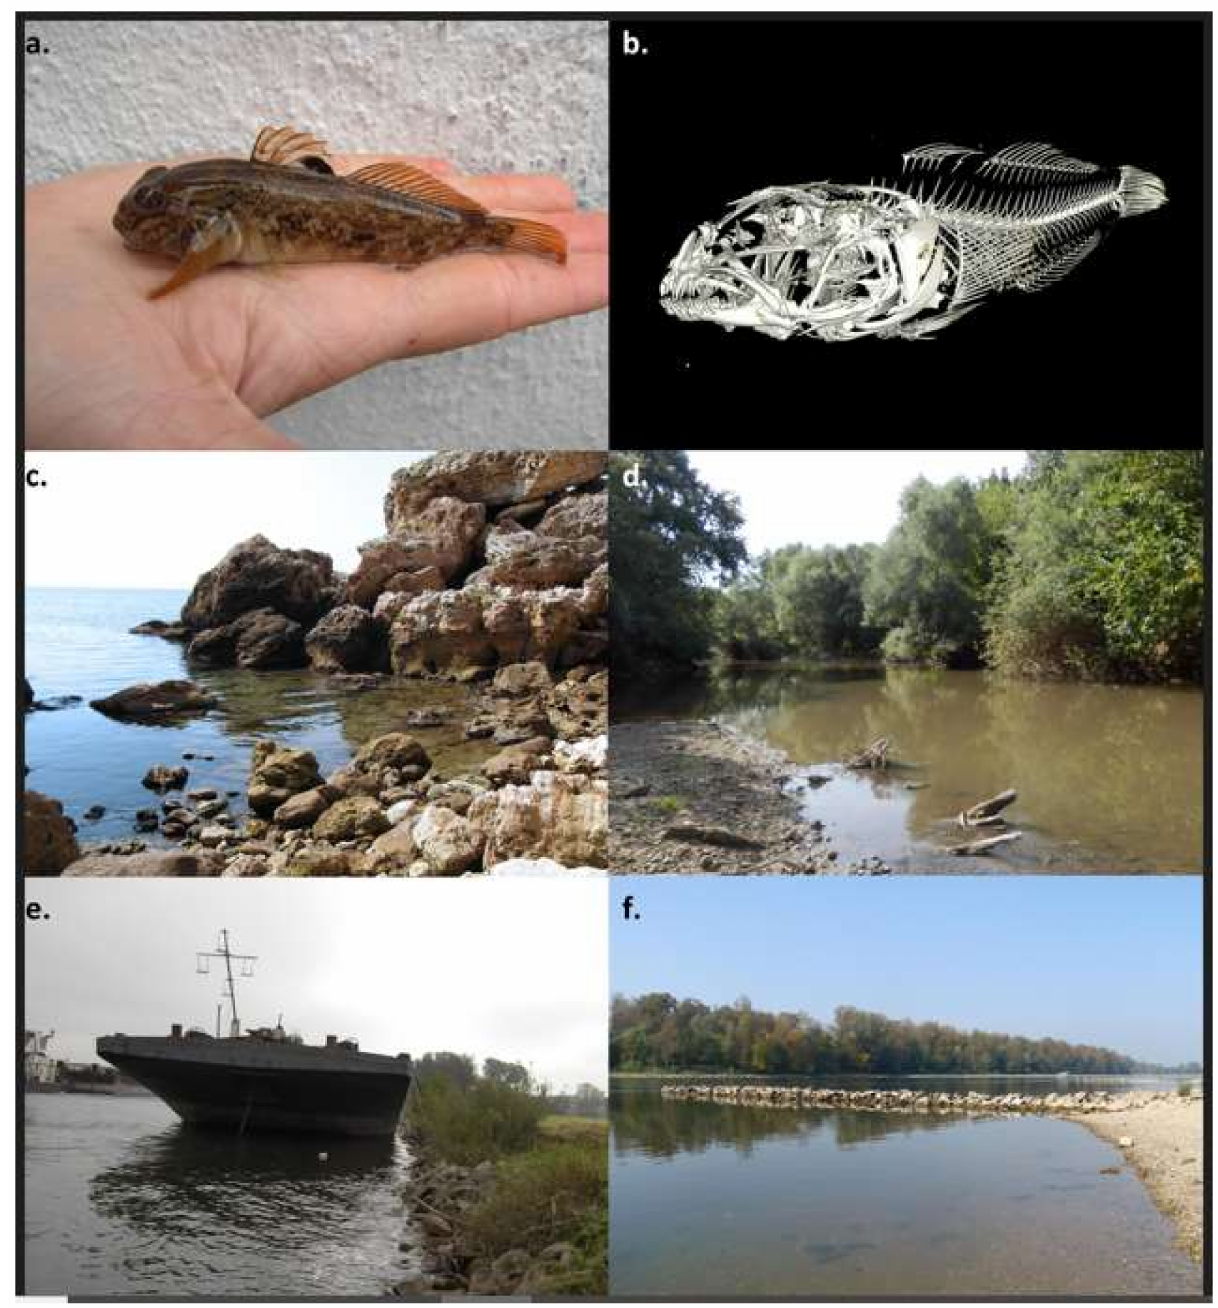
Figure 1. The round goby and its habitat; ( a ) Photograph of a round goby ( Neogobius melanostomus ) specimen from the Danube River in Germany; ( b ) Computerized tomography (CT) scan of the round goby’s skeleton; ( c ) Coastal habitat near Kamen bryag, Bulgaria (Black Sea, native range), ( d ) River Osam near Musalievo village, Bulgaria (right tributary of the Danube, invaded range); ( e ) Rip-rap habitat below Regensburg, Germany (Danube River, invaded range)—a man-made habitat structure preferred by gobies; ( f ) Groins above Mariaposching, Germany (Danube River, invaded